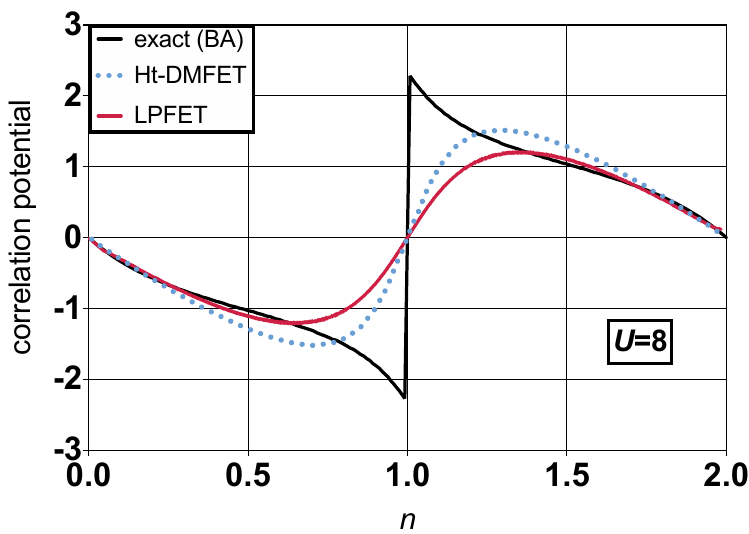
n plotted as a function of the lattice filling n Figure 6. Correlation potential v c ( n ) = µ ( n ) − µ s ( n ) − U 2 at the Ht-DMFET (blue dashed line) and LPFET (red solid line) levels of approximation for U / t = 8. Comparison is made with the exact BA correlation potential (black solid